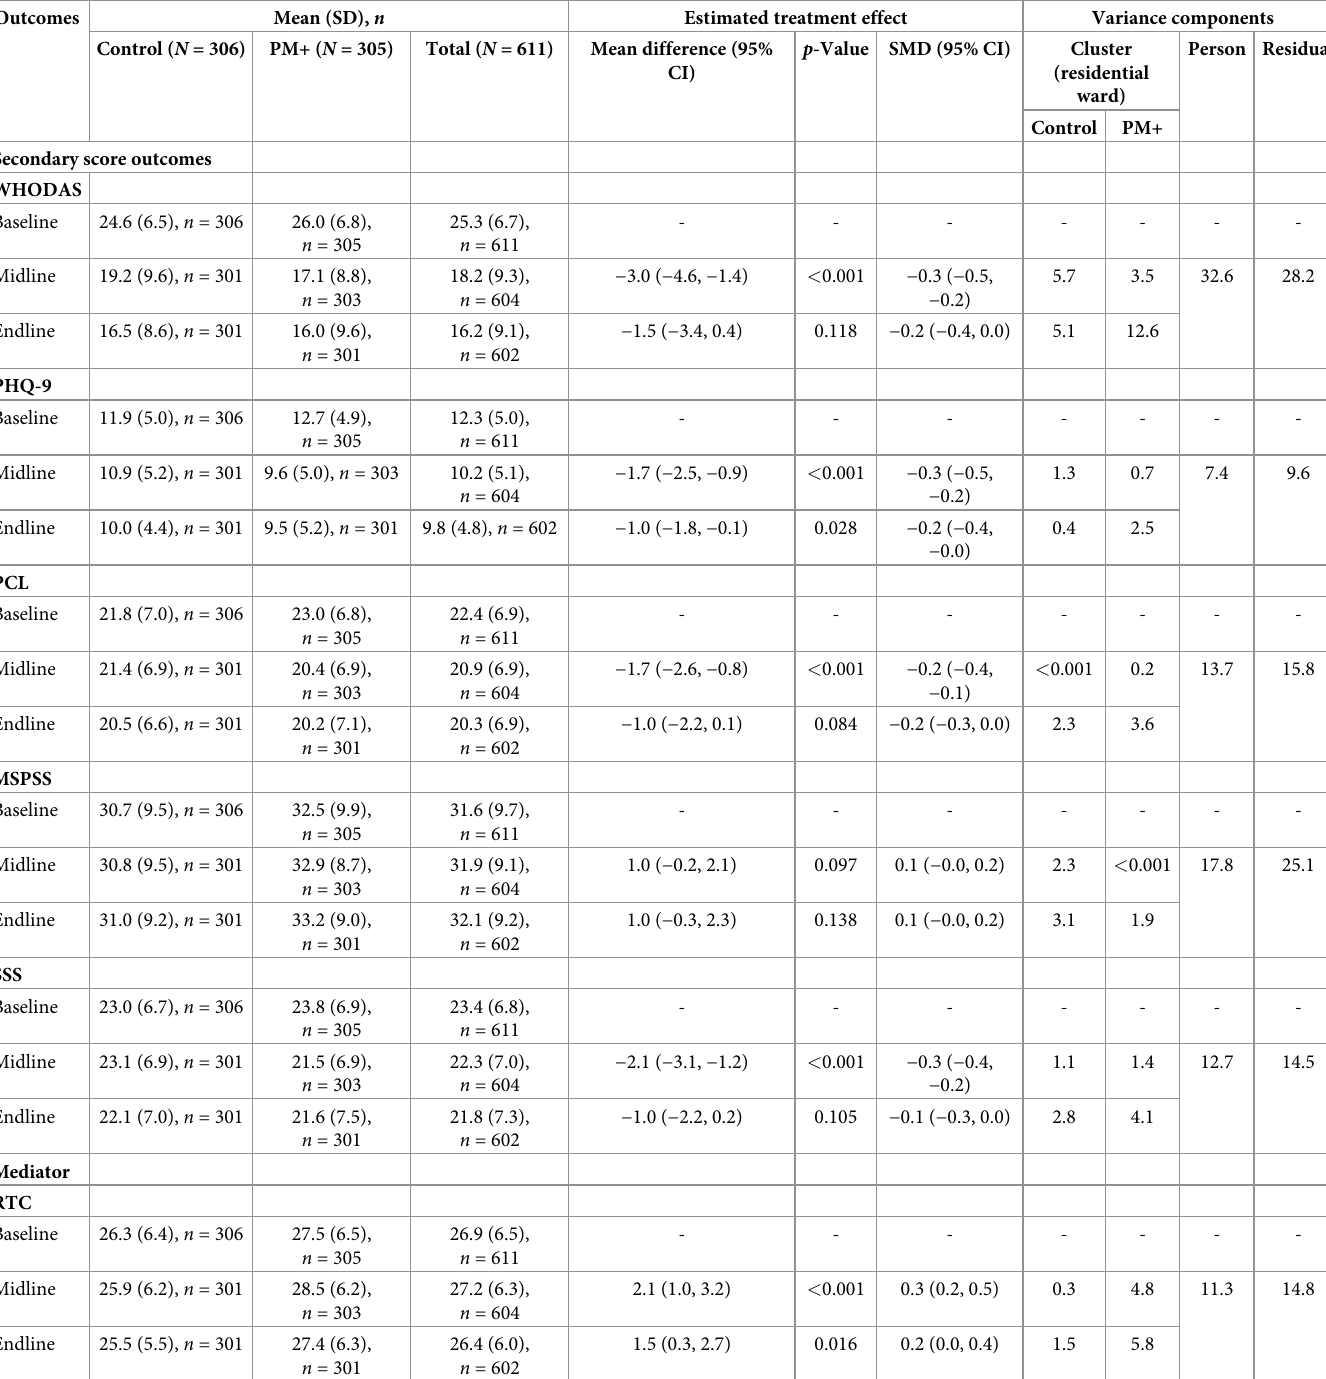
Table 4. Intervention effects a on secondary and mediator score outcomes (mean differences and 95% confidence intervals for the ITT population).